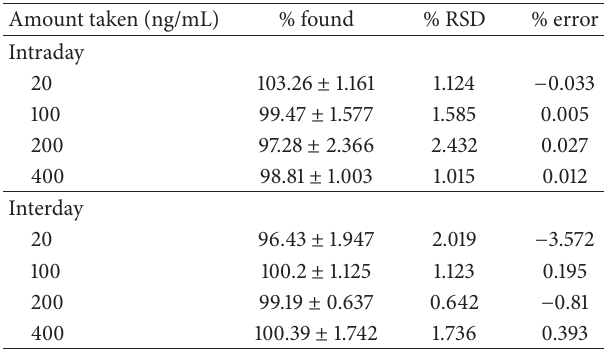
Table 5: Results of weight variation testing of MRZ tablets using the proposed